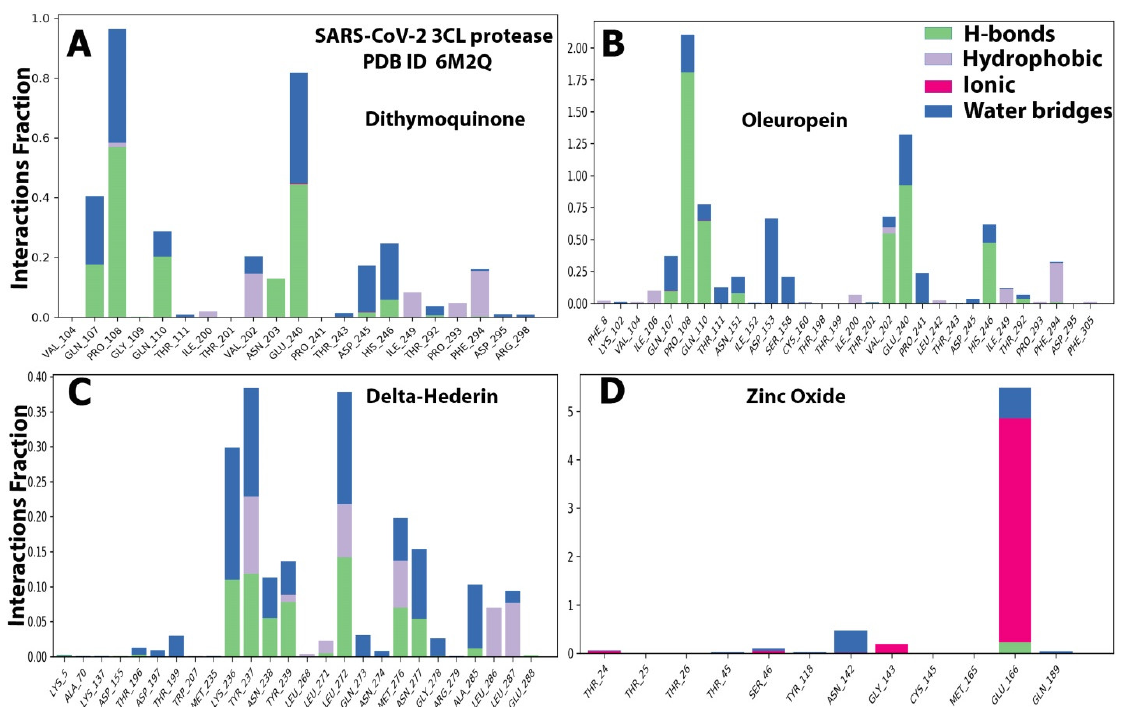
Figure 7. The histograms of protein ligand contact based on the nature of molecular interactions of the four optimized compounds. ( A ) dithymoquinone, ( B ) oleuropein, ( C ) delta-hederin, and ( D ) zinc oxide throughout the trajectory. The RMSD value for both the ligands and protein was calculated and noted from the graph and at the start of the simulation process for protein. However, massive fluctuations were observed up to 10 ns for dithymoquinone, which was followed by an equilibrium state 2.4 Å during simulation time. For the ligand, the RMSD value was noted to be 4.0– 6.4 Å after half the time of the simulation, whereas the least fluctuations exhibited between 4.55 Å to 6.2 Å during the rest of the time (Figure 8A). For oleuropein, fluctuations were observed from 40–60 s. At the beginning of the simulation, the protein showed stable in- teraction between 1.2–2.4 Å. For the ligand, most of least fluctuations were observed from 4.0 Å to 4.8 Å (Figure 8B). δ-Hederin showed the most stable protein–ligand interaction with least and brief fluctuation after 80 ns. For the protein, least fluctuations were exhib- ited between 2.0 Å to 2.8 Å, while the ligand exhibited it between 9 Å to 15 Å (Figure 8C). Similarly zinc oxide showed only massive fluctuations after half time of the simulation (Figure 8D). Figure 8E represents the apo-form control for comparison.